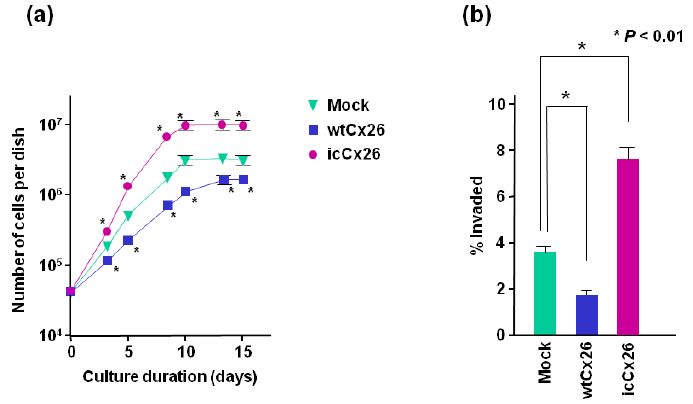
Figure 3. Effects of wtCx26 and icCx26 proteins on cell proliferation and invasion capacity in vitro of FaDu cells. ( a ) Growth curve of each clone of FaDu cells. The wtCx26, icCx26, and mock clones were cultured for the indicated periods. The cells were counted every 2 or 3 days in triplicate dishes. Error bars represent the SD ( n = 3). No error bar is indicated when the SD is too small to show. * p < 0.001 (significantly different from the mock clone at the corresponding time point). ( b ) Invasion capacity of each clone into the matrix basement membrane. The cells were seeded onto Matrigel, which had been settled on cell culture inserts in advance. The cells that infiltrated into the Matrigel layer were counted and their proportion to the total cell number is indicated. Error bars represent the SD ( n = 6).